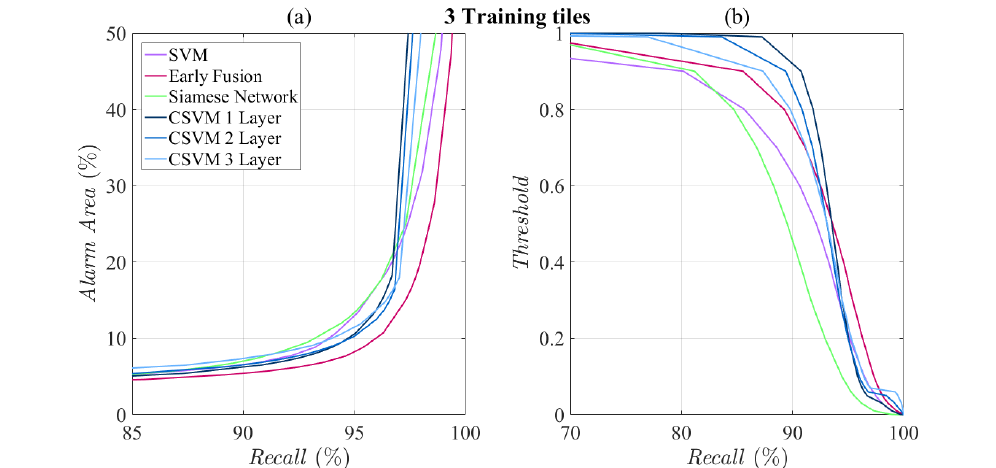
Figure 23. ( a ) Recall vs. Alarm Area (deforested area) for Cerrado biome using three training tiles. ( b ) The recall values are obtained by threshold